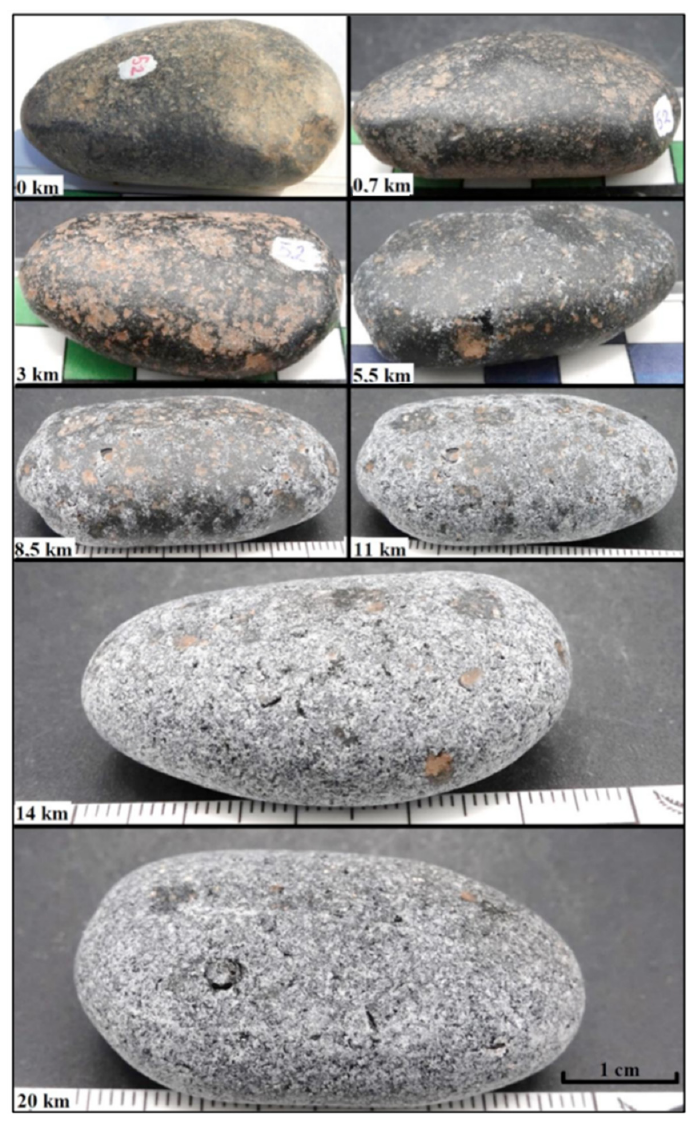
Figure 9. Sample 52. Transport effects (from 0 to 20 km).